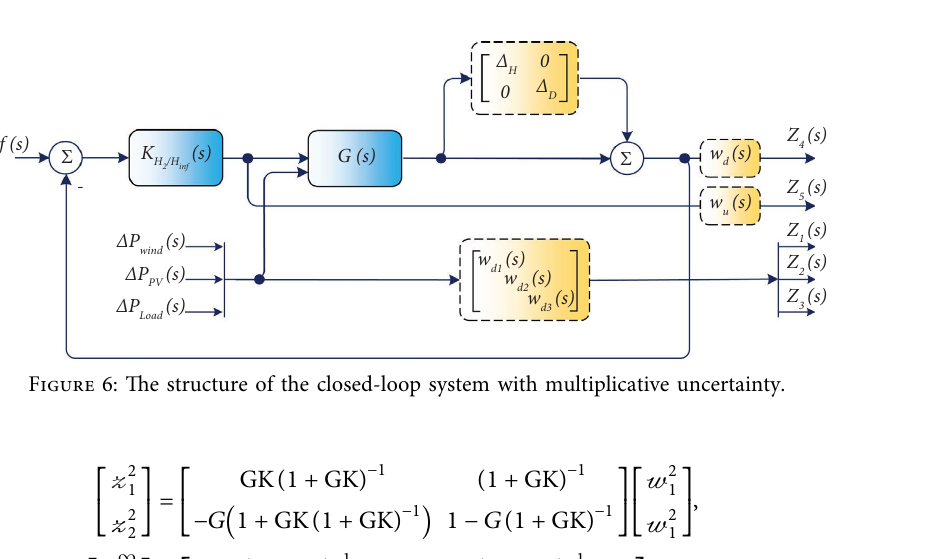
for NP, (c) performance of the uncertain system, and (d) the wy and uncertain system. wy